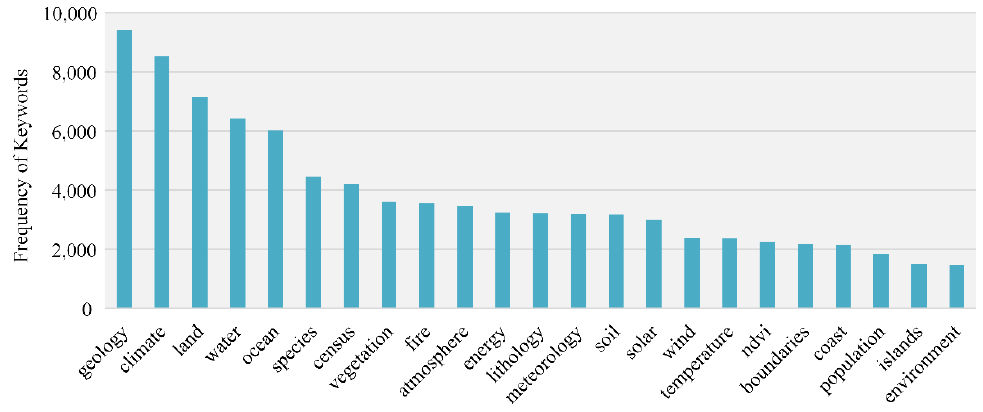
Figure 8. Top English language keywords found in service descriptions for map layers.